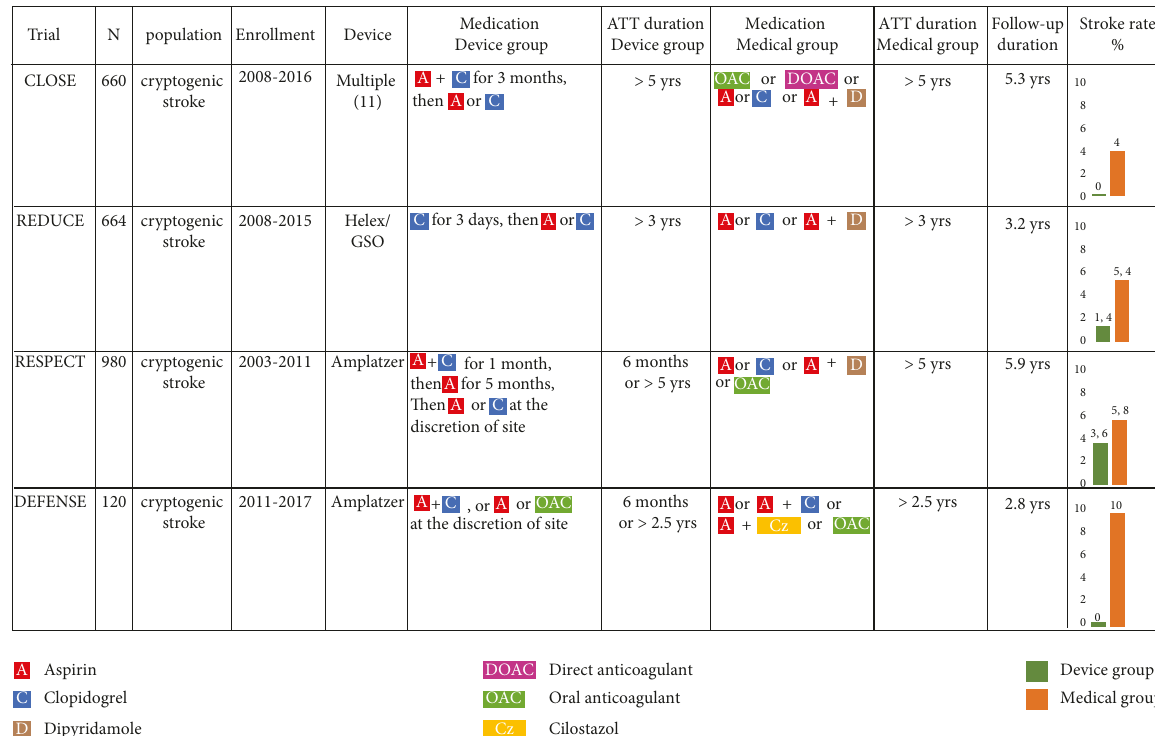
Figure 1: Recent randomized studies on PFO closure versus medical therapy after cryptogenic stroke: Rates of events and antithrombotic strategies. N � number of patients; ATT � antithrombotic therapy; GSO = Gore Cardioform Septal Occluder.